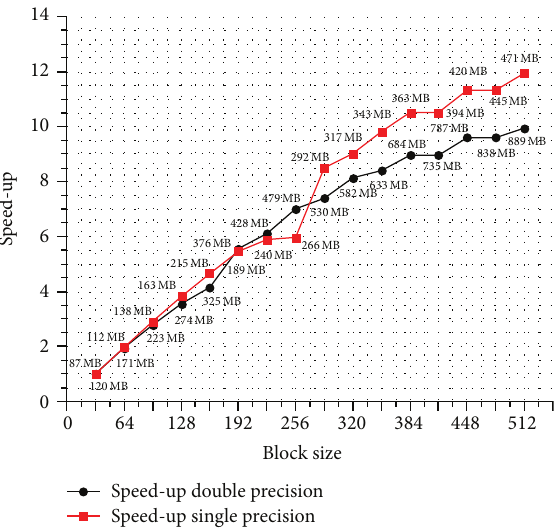
Figure 7: Comparison of the execution time using a variable block size in multiples of 32, in double and single precision.